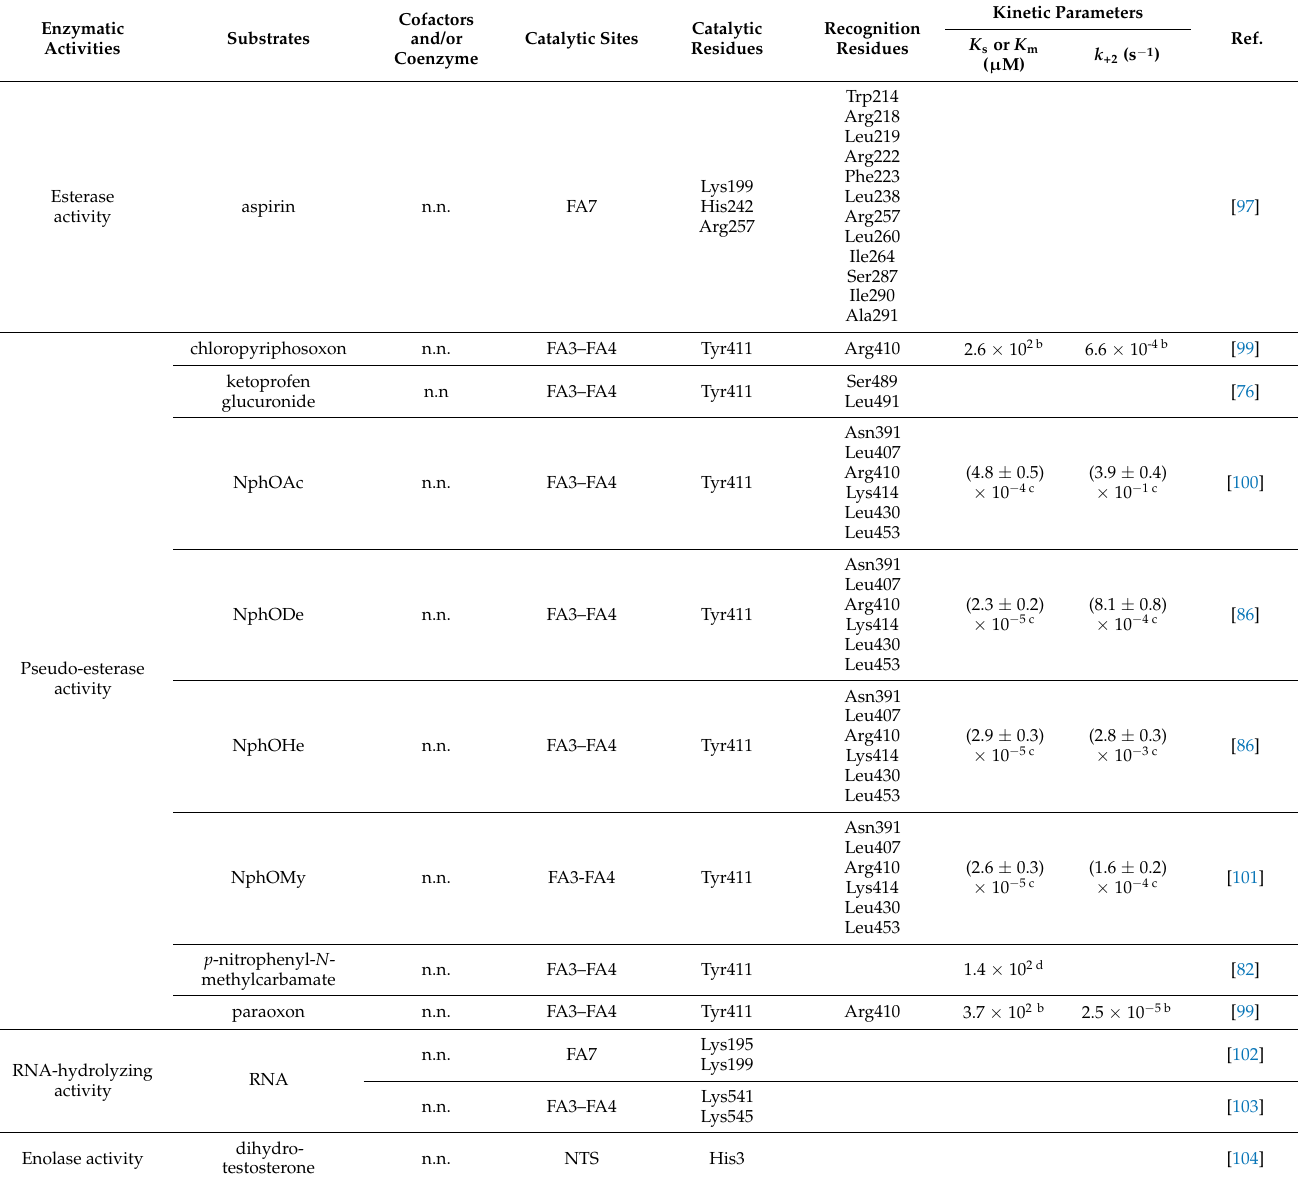
Table 1. Catalytic properties of HSA a